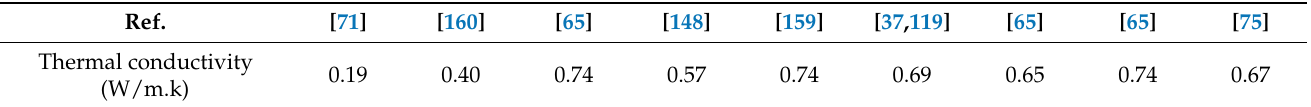
Table 2. Values of thermal